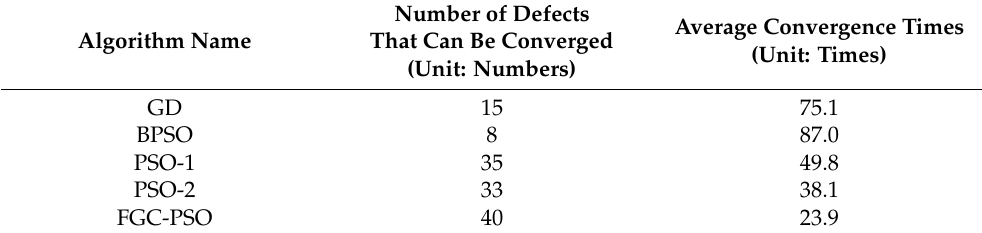
Table 3. Convergence statistical results of 40 defects with 13 DOFs.